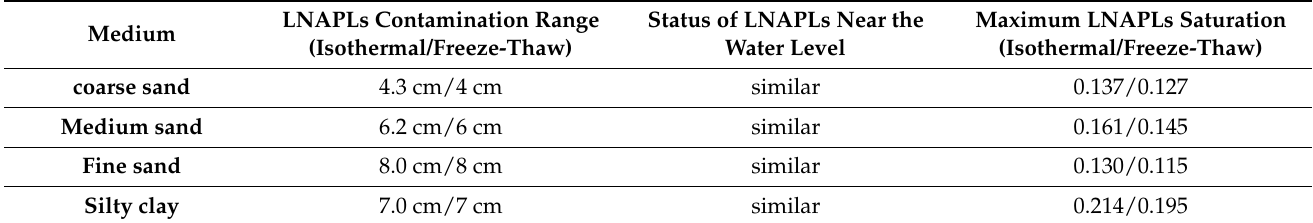
Table 4. Comparison of LNAPL migration status during isothermal and the freeze–thaw